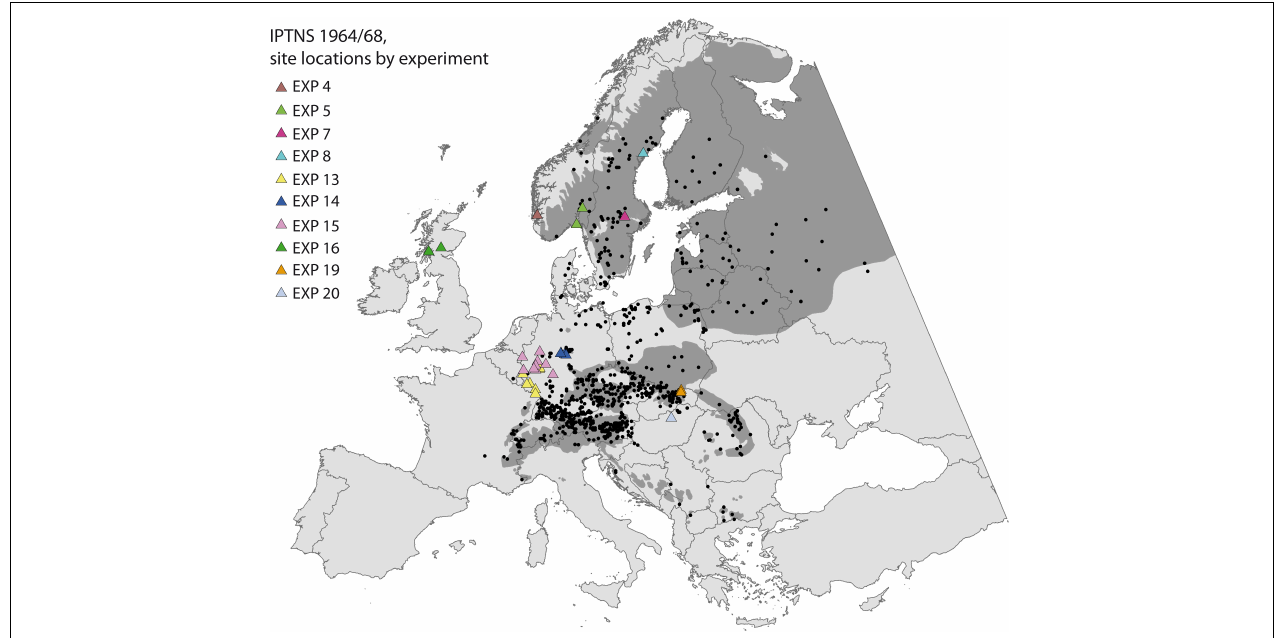
FIGURE 1 | Sampled populations (black points) and trial sites (triangles, colored by correspondence to experiment) of the International Provenance Test 1964/68 of Norway spruce (IPTNS) used to calibrate the TraitSDM. The natural distribution of Norway spruce is shaded in dark gray (Skrøppa,